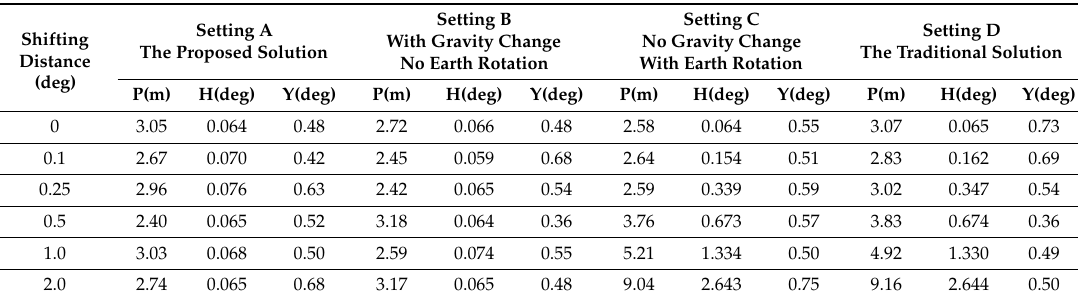
Table 3. The RMSEs of the position, horizontal attitude, and yaw of MTi-G-710 under different settings for the sequence at the test area of the Guanggu financial harbor (GFH).